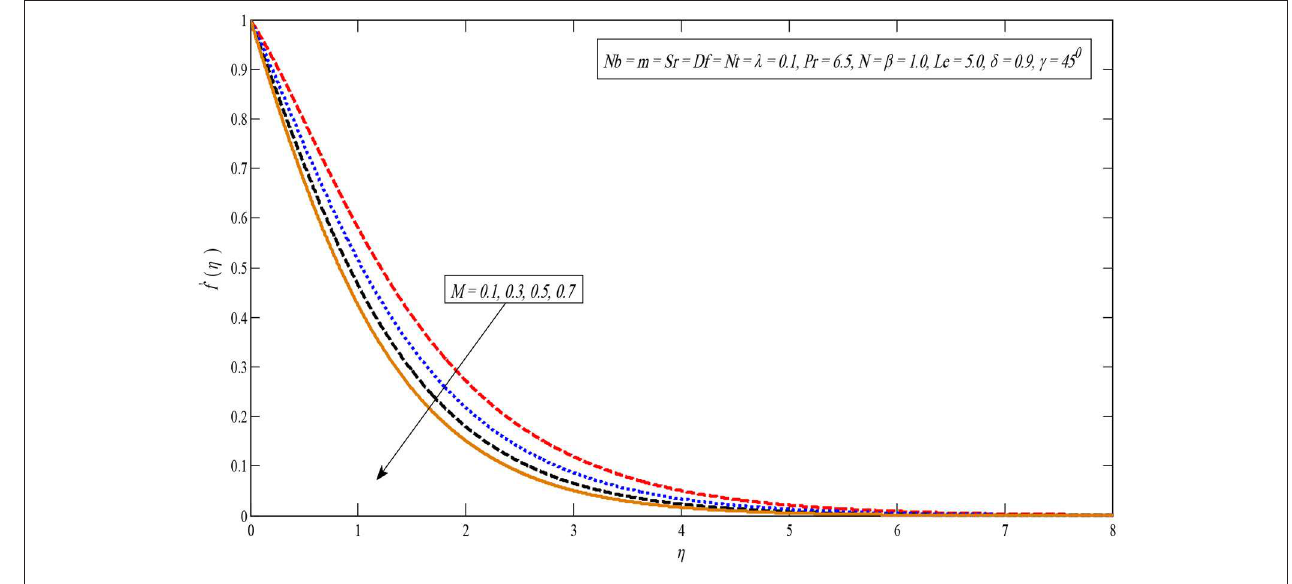
FIGURE 2 | Velocity profile for several values of M .